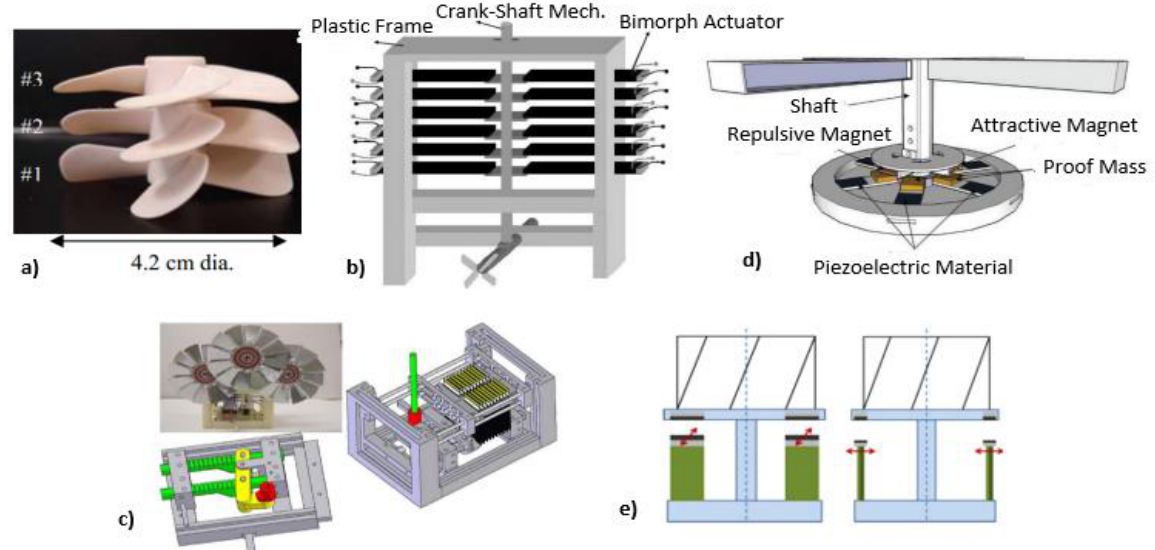
Figure 3. ( a ) Testing of three propellers with different pitch angles; ( b ) pictorial view of rectangular piezoelectric windmill; ( c ) schematic of optimized three-fan blades in rectangular piezoelectric windmill; ( d ) contactless piezoelectric wind-turbine schematic featuring magnetically driven piezoelectric elements; ( e ) unregular piezoelectric wind-turbine schematic with parallel and circular configurations [83].